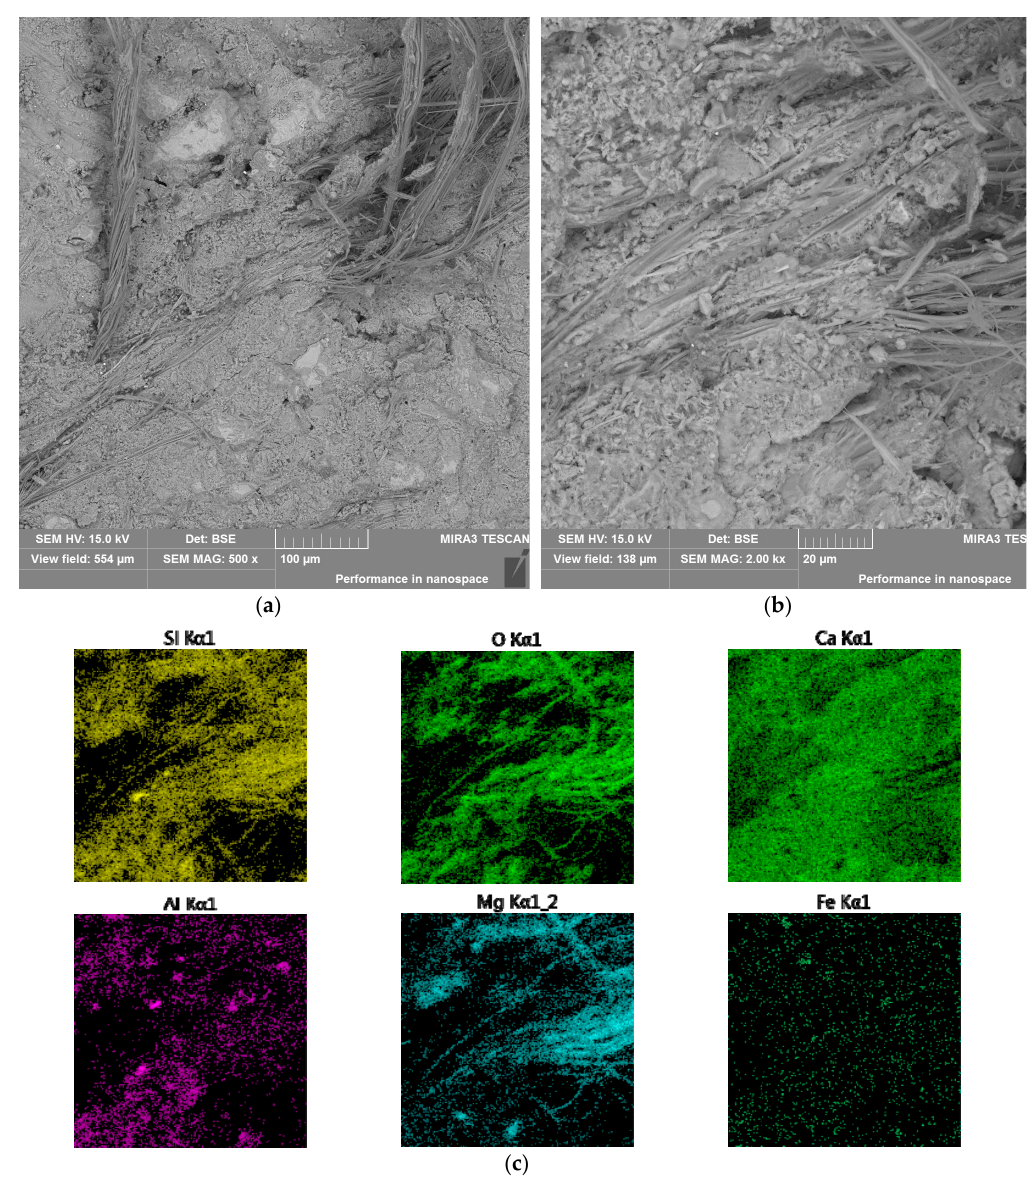
Figure 4. Scanning electron microscopy (SEM) images of the asbestos-containing materials (ACM) sample: Surface; 500 × ( a ); fracture; 2000 × ( b ) and corresponding fracture Energy Dispersive Spectroscopy ( EDS) elemental maps ( c ).